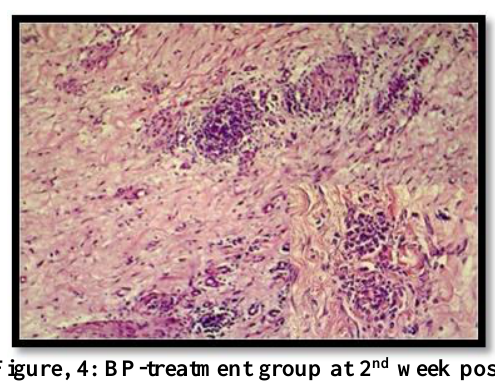
Figure, 7: BP-treatment group at 8 th week post implantation shows vascular (immature) granulation tissue (H&E stain, ).